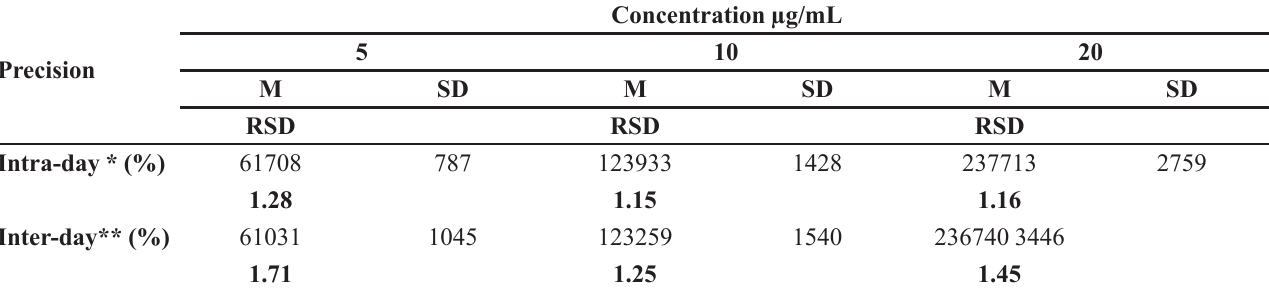
TABLE VI - Intra-day and inter-day precision